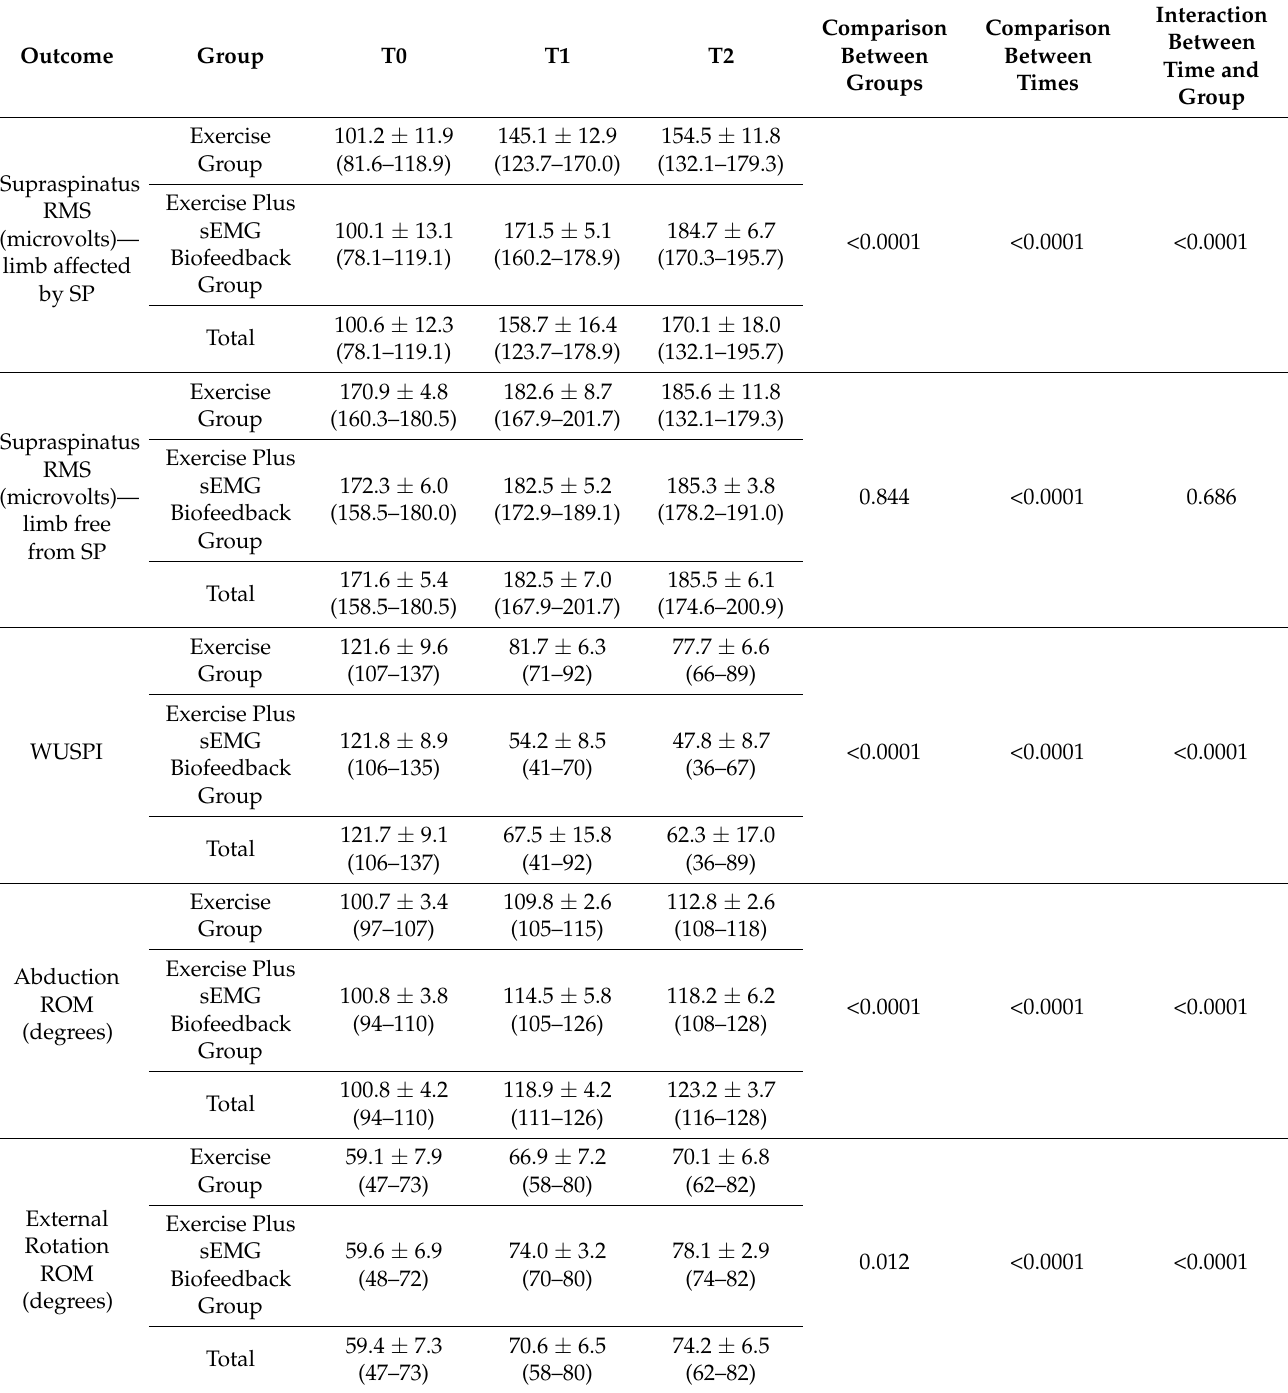
Table 2. Mean ± standard deviation (range) of the outcomes, by group and detection time.